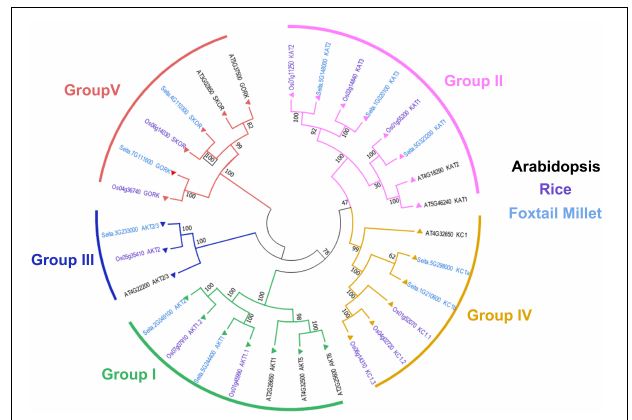
FIGURE 1 | Phylogenetic analysis and classification of Shaker K + channel proteins from foxtail millet (light blue), Arabidopsis (black), and rice (purple). Shaker K + channels are divided into five distinct groups denoted by different colored lines.